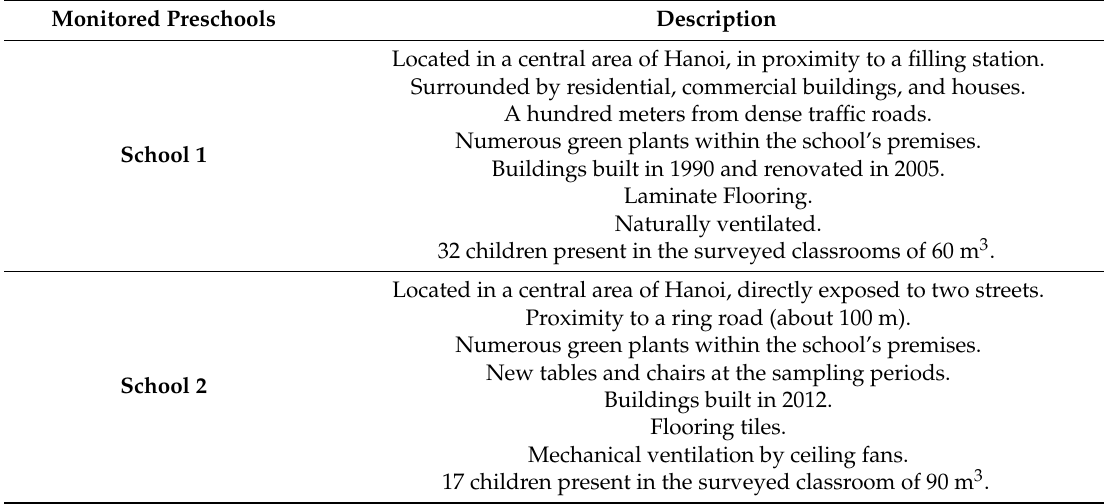
Table 1. List of main characteristics of the monitored